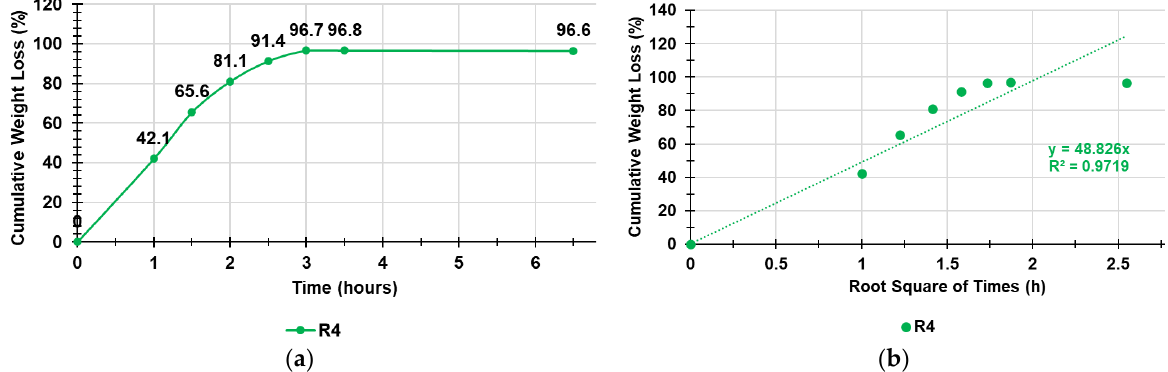
Figure 7. Cumulative weight loss percentage curve of SR4 over time and gentle heating ( a ); Higuchi kinetic model fitting data of the cumulative weight loss curve ( b ).